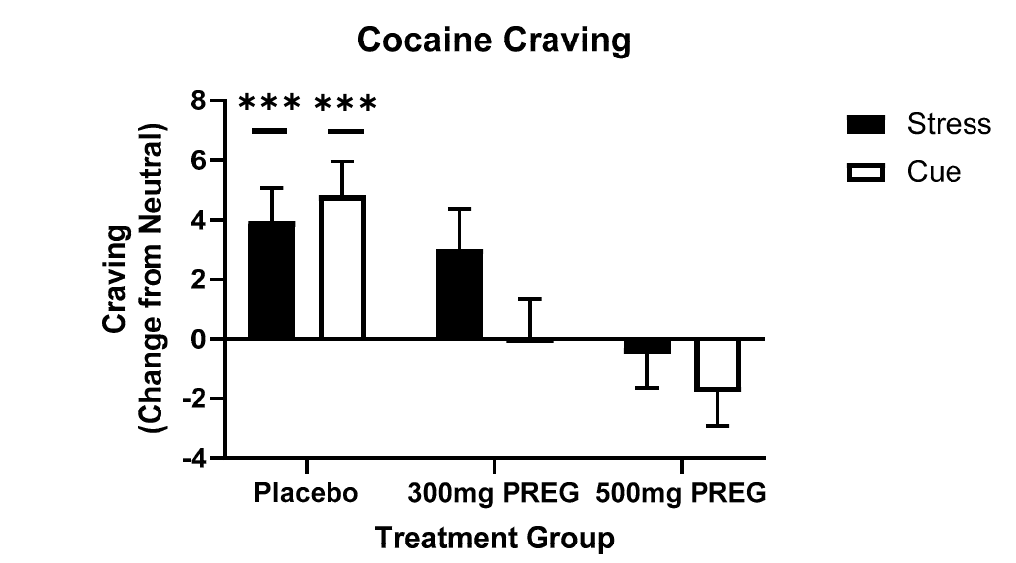
Figure 3. Provoked cocaine craving as a function of imagery condition and placebo vs. PREG treat- ment groups. Cocaine craving was significantly higher in the stress condition ( p = 0.001) and the cocaine cue condition ( p < 0.001) compared to the neutral condition in the placebo group. In the 300 mg PREG and 500 mg PREG groups stress- and cocaine cue-provoked craving was not signifi- cantly different than neutral ( p = n.s.). All data are displayed as mean ± S.E.M. *** p <